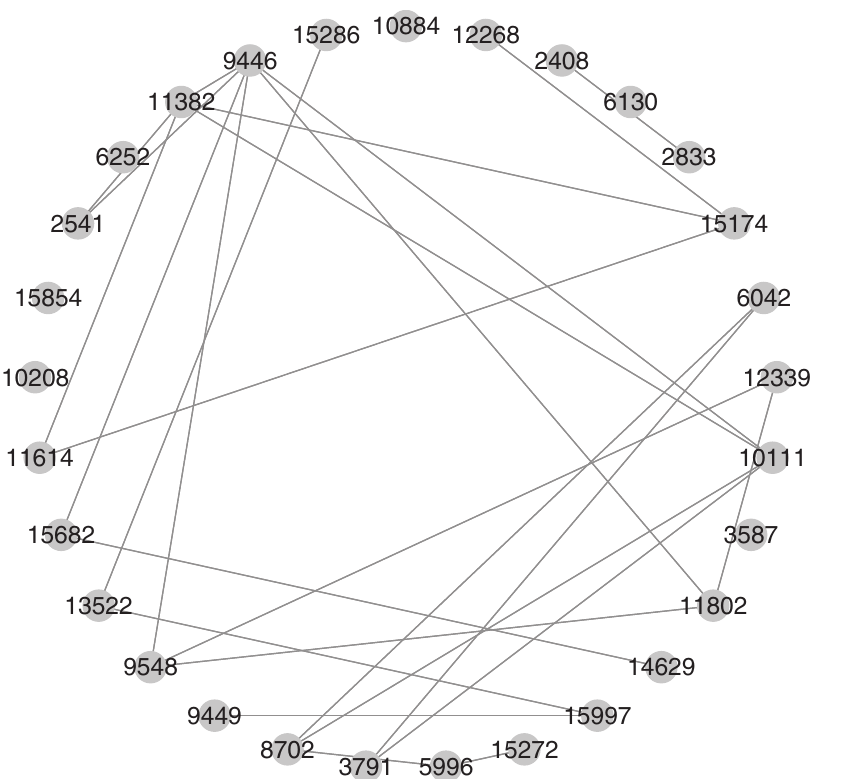
Fig 2. The whole network structure with selected gene